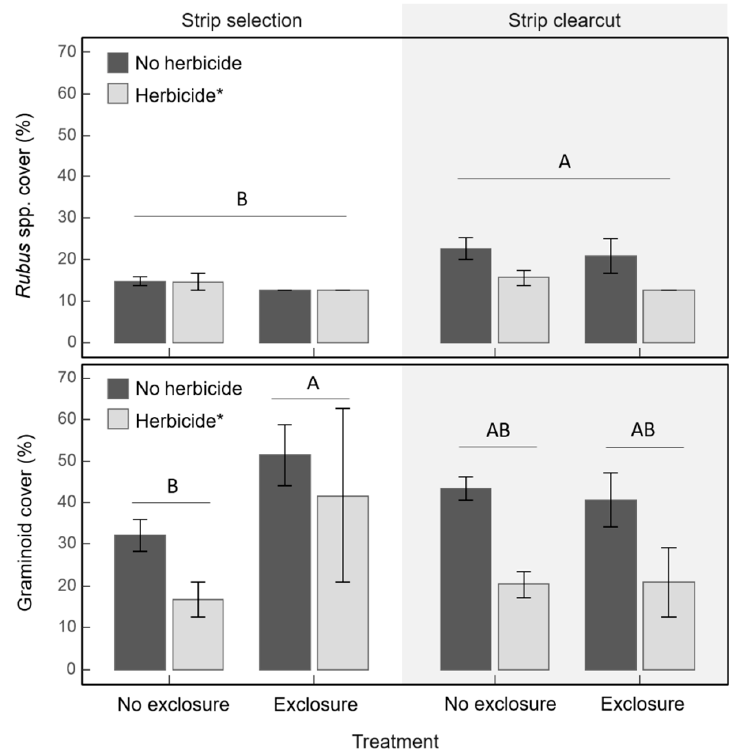
Figure 4. Average ( ± 1 SE) Rubus spp. and graminoid cover among harvest, herbicide, and exclosure treatments in a managed northern hardwood forest in the Upper Peninsula of Michigan, USA. Cover among three 1 m 2 subplots was averaged prior to analysis ( n = 107). Letters indicate significant differences among harvest or exclosure treatments within each cover type. *Asterisk indicates a significant herbicide effect.